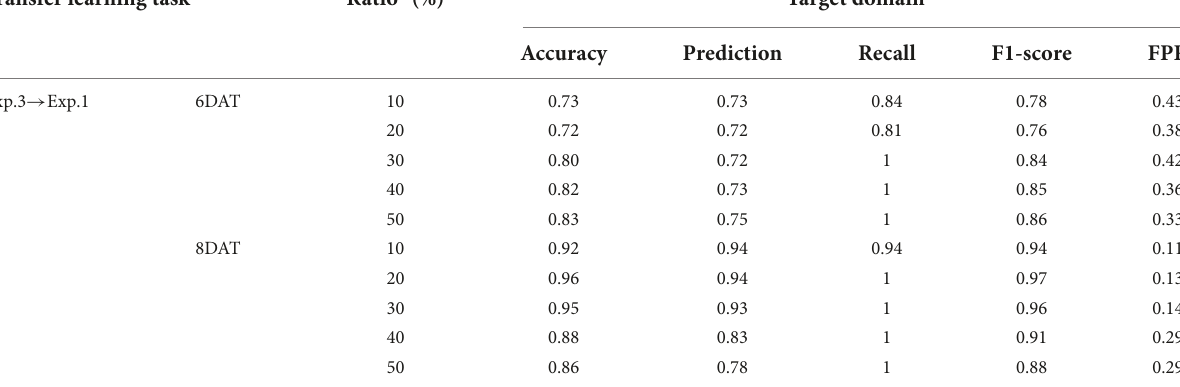
TABLE 5 Prediction results of transfer component analysis- and source domain updating-based support vector machine models on new target domain in transfer learning task (Exp.3 → Exp.1). Transfer learning